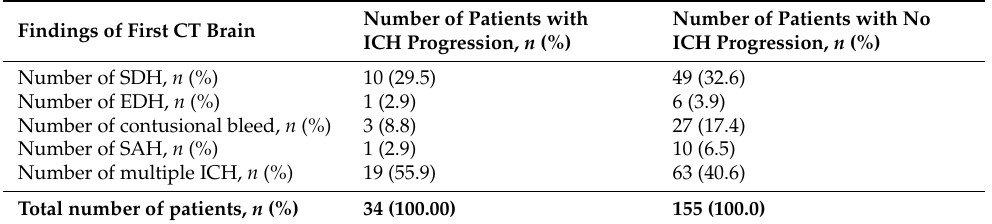
Table 2. Baseline ICH in the first CT in relation with ICH progression (F = 0.25, p = 0.62).